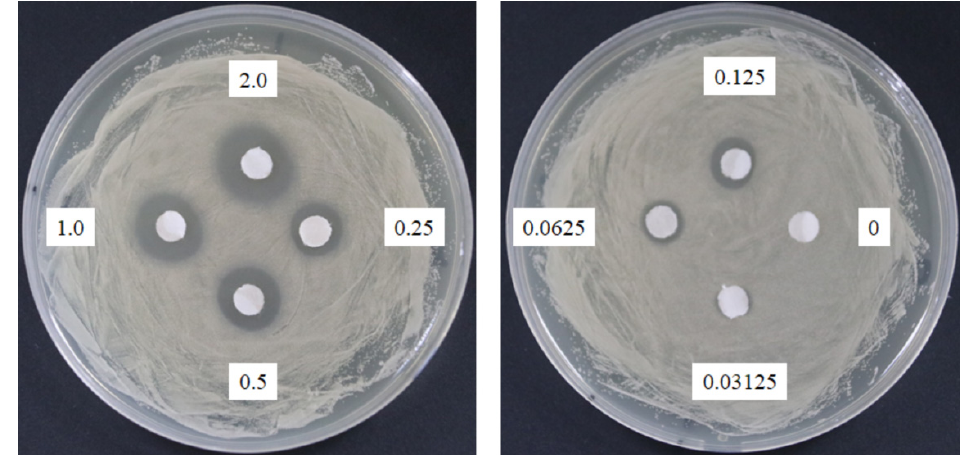
Figure 8. Anticandidal activity analysis of sasanquasaponin III. The 6 mm paper discs with different concentrations of sasanquasaponin III (0, 0.03125, 0.0625, 0.125, 0.25, 0.5, 1, and 2 mg) were placed on the plates with spread C. albicans . The plates were cultured at 37 °C for 24 h, and the growth inhibitions of C. albicans were observed.